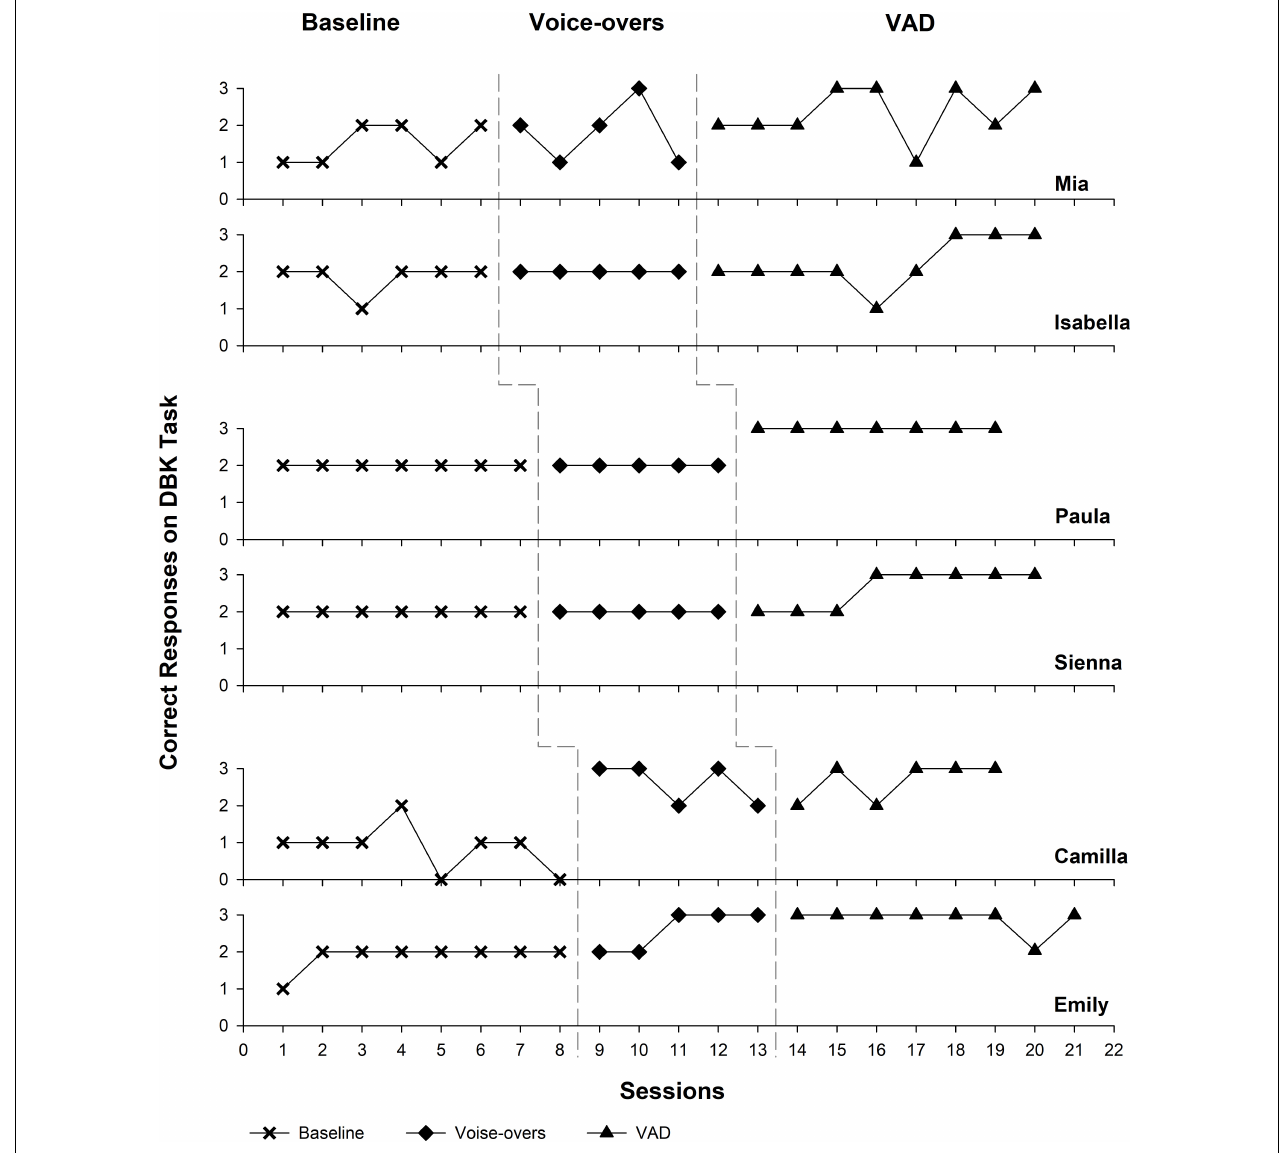
FIGURE 1 | Accuracy of responses to the three tasks in Desires, Beliefs, Knowledge measure by participants across the research